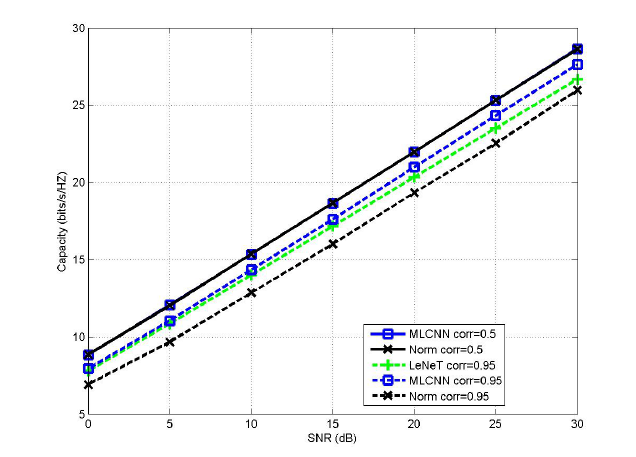
Figure 4. Channel capacity performance comparison between MLCNN-aided AS, LeNet-based AS and NBAS for ( 32,32;2,32 ) MIMO IoT system under correlation coefficients of corr = 0.50 and